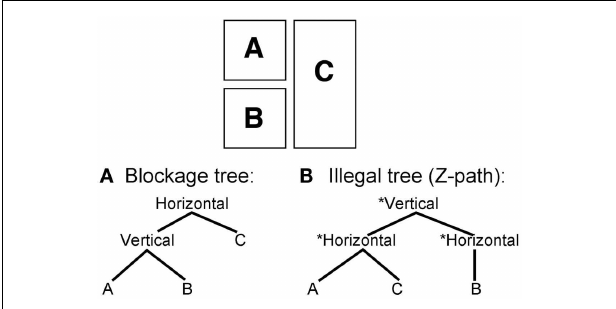
FIGURE 8 |Tree structures for the reading orders of blockage using (A) a strategy followingAssemblage, or (B) an infelicitous Z-Path.